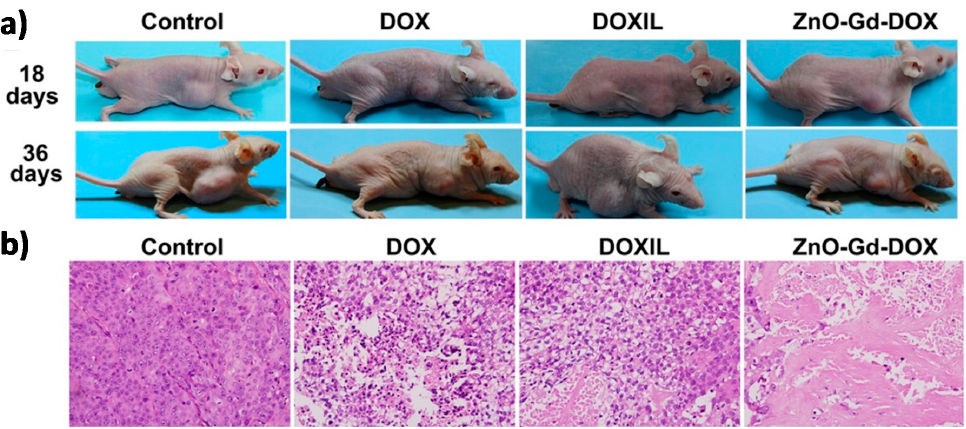
Figure 3. ( a ) Images of BxPC-3 tumour-bearing nude mice after 18 and 36 days under different treatments; ( b ) H&E staining of tumour slices after 36 days of treatments by different agents. Reproduced with permission from [34]. American Chemical Society, 2016.